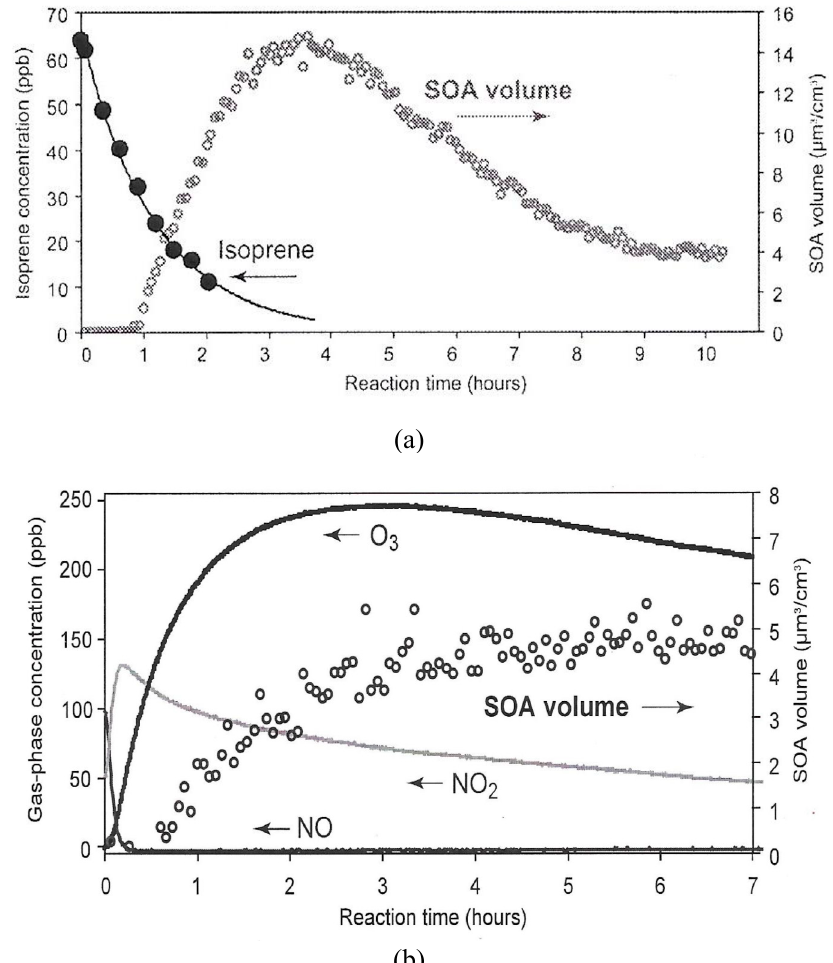
Figure 8. Examples of SOA production measured in terms of average particle volume change with irradiation time. Particle formation at low initial NO x concentration in air ( < 1ppb), 63.6 ppb isoprene without inorganic seed ( a ) compared with high initial NO x concentrations (98 ppb NO; 31 ppb NO 2 ); 42.7 ppb isoprene, and 6.4 µ g / m 3 (NH 4 ) 2 SO 4 seed ( b ) (Reprinted from [194] with permission from the American Chemical Society).